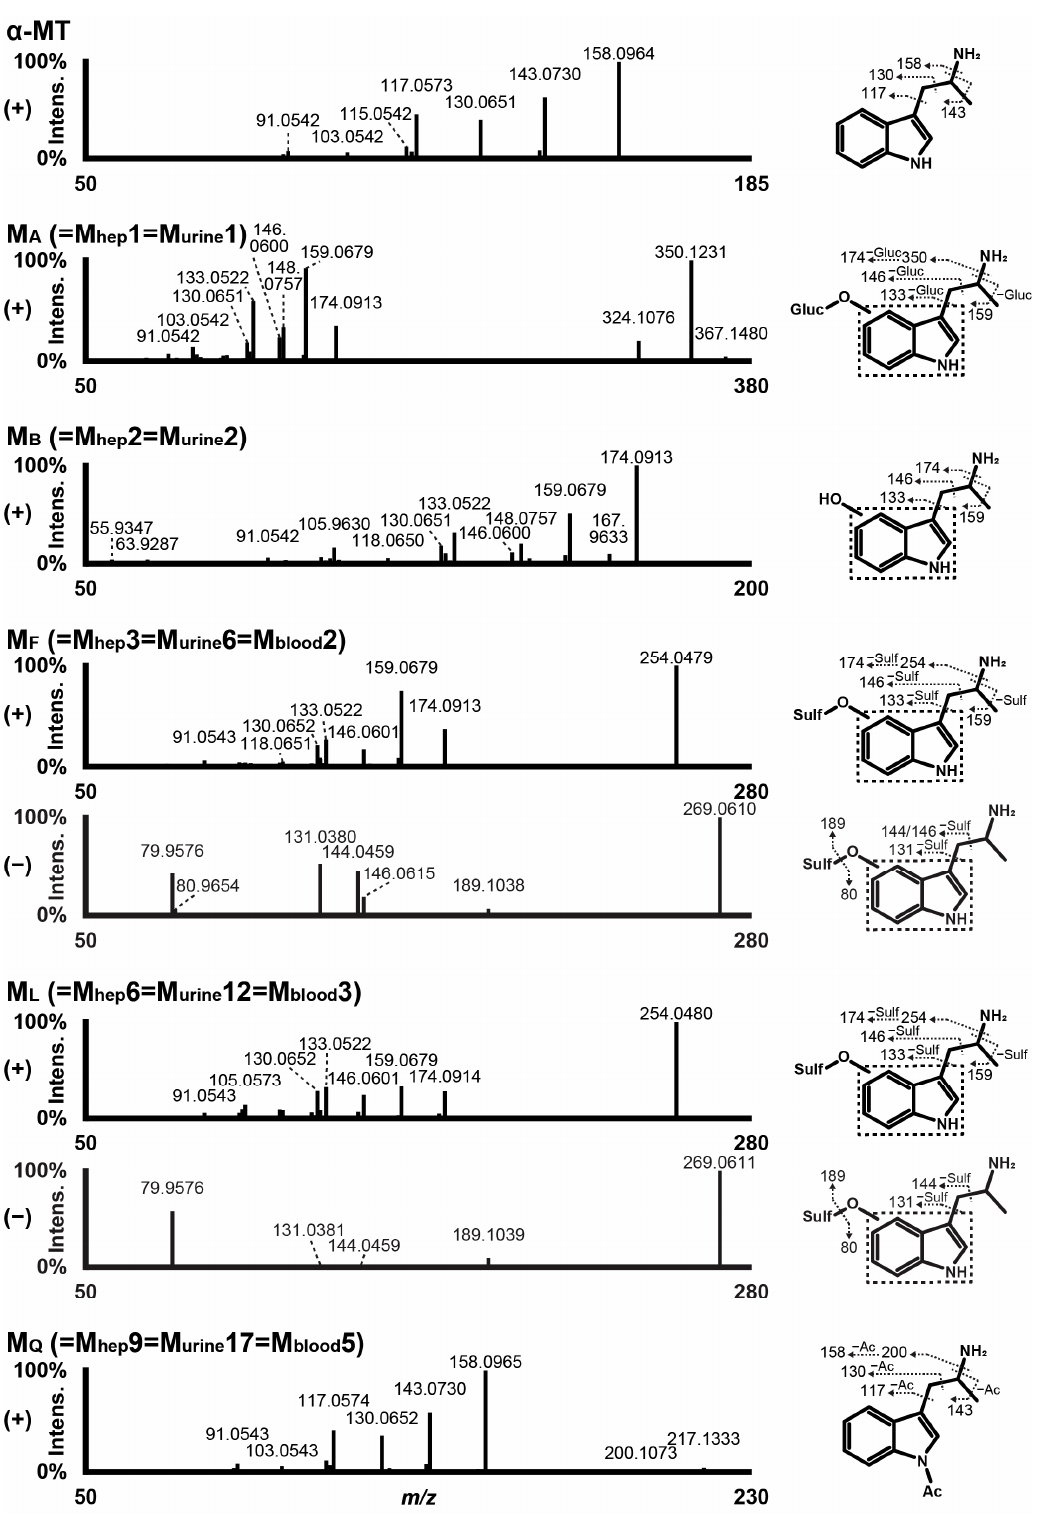
Figure 1. Fragmentation pattern of α -MT and major metabolites in liquid chromatography-high- resolution tandem mass spectrometry. We suggest M A , M F , and M L as biomarkers of α -MT use in non-hydrolyzed urine, α -MT and M B in hydrolyzed urine, and α -MT, M F , M L , and M Q in blood. (+), positive-ionization mode; ( − ), negative-ionization mode; Ac, acetyl; Gluc, glucuronide; Sulf, sulfate; dotted box, Markush structure.